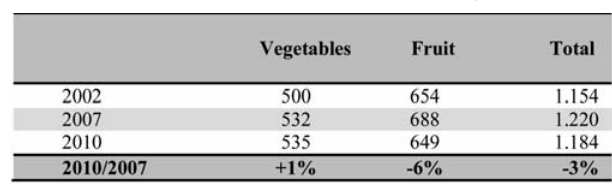
Table 1. Household purchases of fresh fruit and vegetables in the Netherlands (kg × 1000) (Number of households: 2002 = 6.93 million, 2007 = 7.22 million, 2010 = 7.39 million)